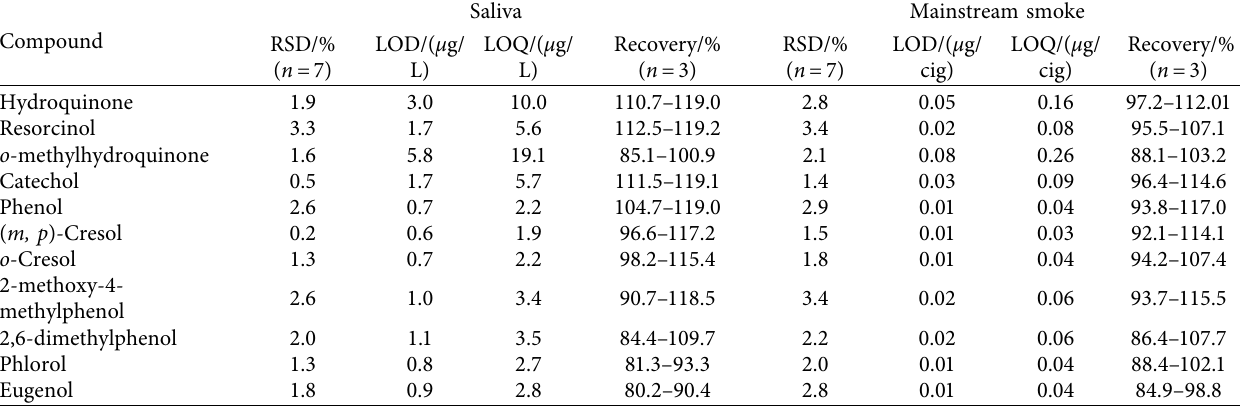
Table 2: LODs, LOQs, RSDs, and recoveries for 12 analytes in saliva and mainstream smoke samples.